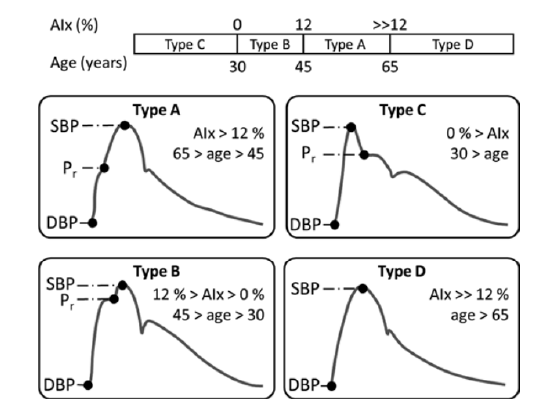
Figure 9. Visualization of typical blood pressure morphologies dependent on age group. Reprinted with permission from [5]. © 2019, Springer Nature Switzerland AG.